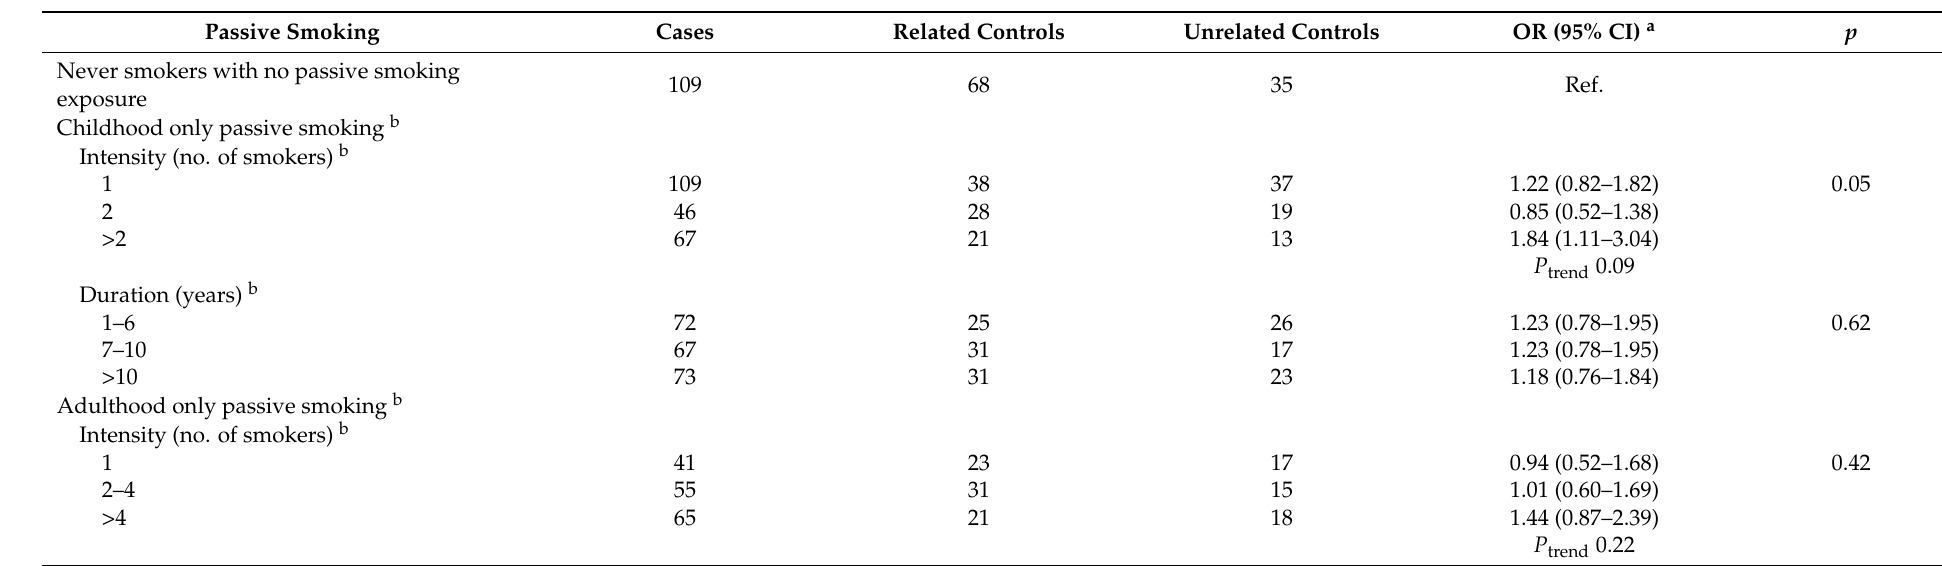
Table 3. Odds ratios and 95% confidence intervals for FL risk in relation to passive smoking exposure among never